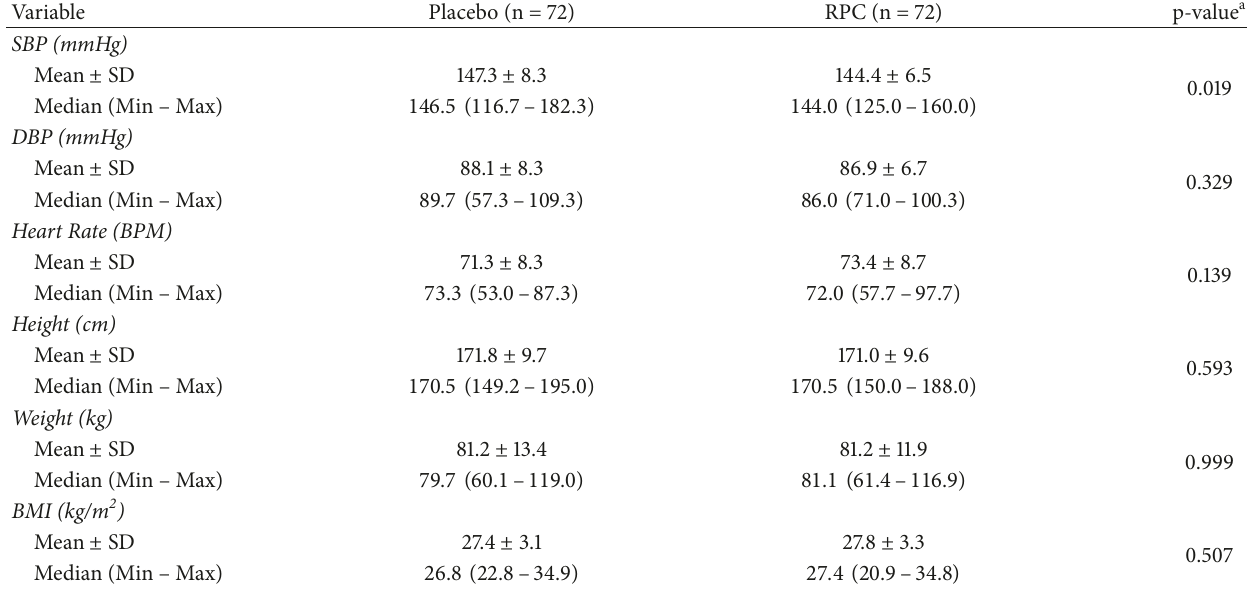
Table 2: Baseline measurements for the placebo and RPC groups in the ITT population (n=144).